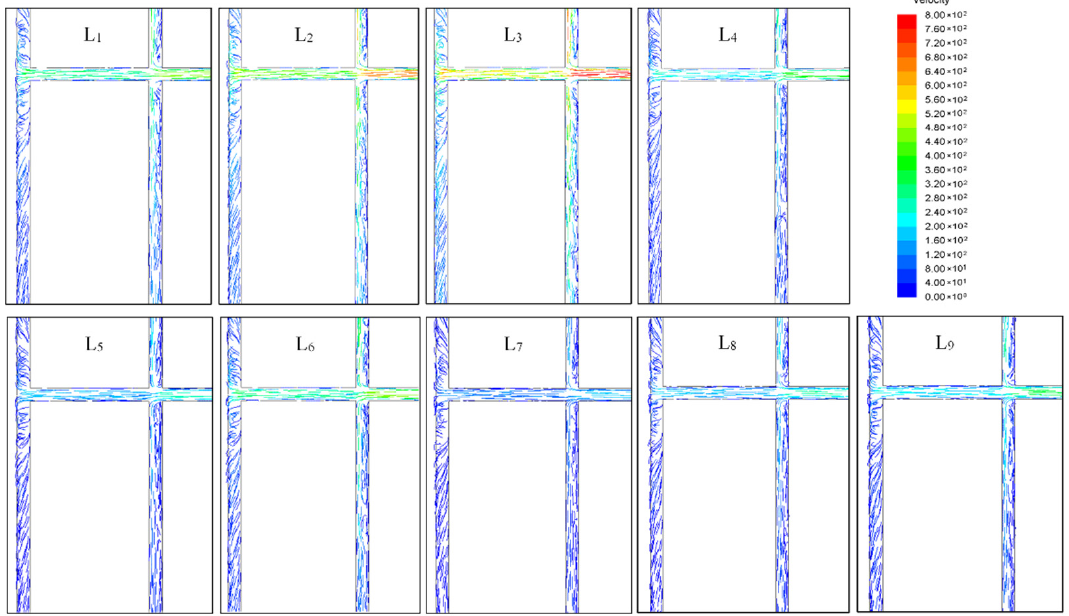
Figure 5. Color map of velocity path-line near the air door.